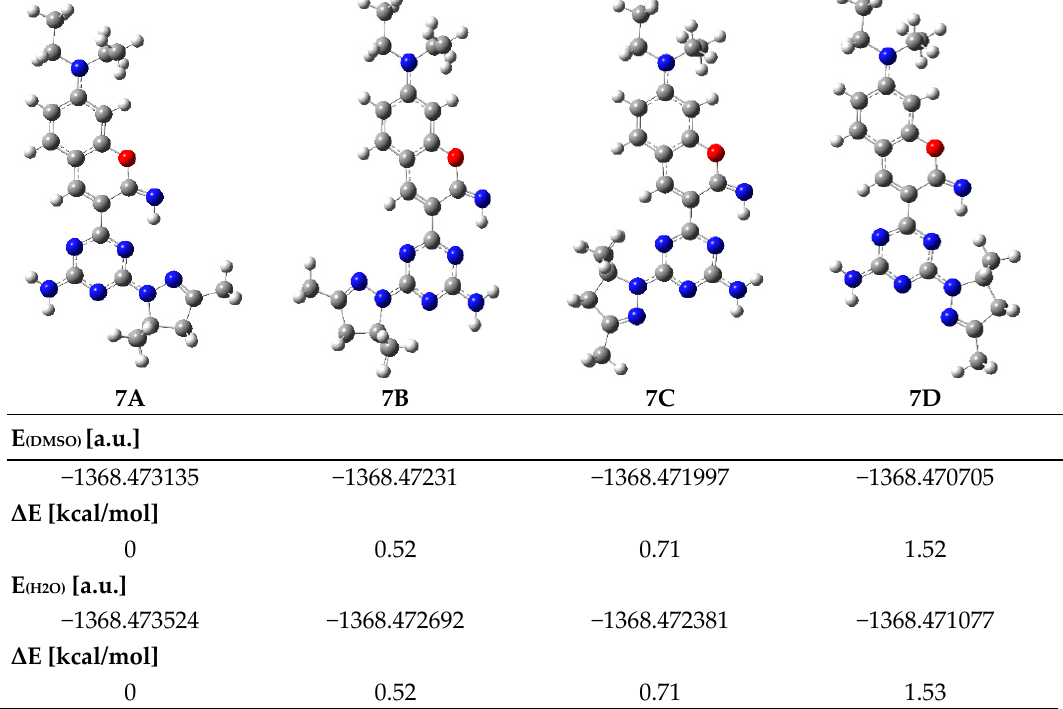
Figure 2. Structures of optimized rotamers 7A – D and corresponding electronic energies (E) and relative energies ( Δ E) calculated at B3LYP/6–31(d) level of theory [70] using polarizable continuum model (PCM) solvation model [71].